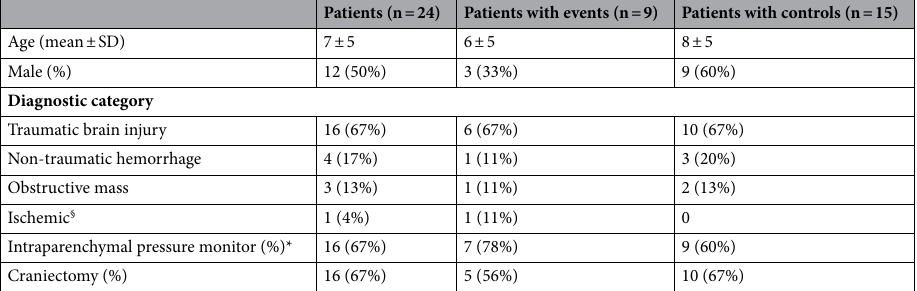
Table 1. Clinical characteristics of patients who had elevated ICP events vs patients who had no elevated ICP events. § Suffered a thrombotic stroke and cardiac arrest. *Remainder had externalized ventricular drains (EVD). One patient had data from both an EVD and intraparenchymal pressure monitor but not simultaneously.